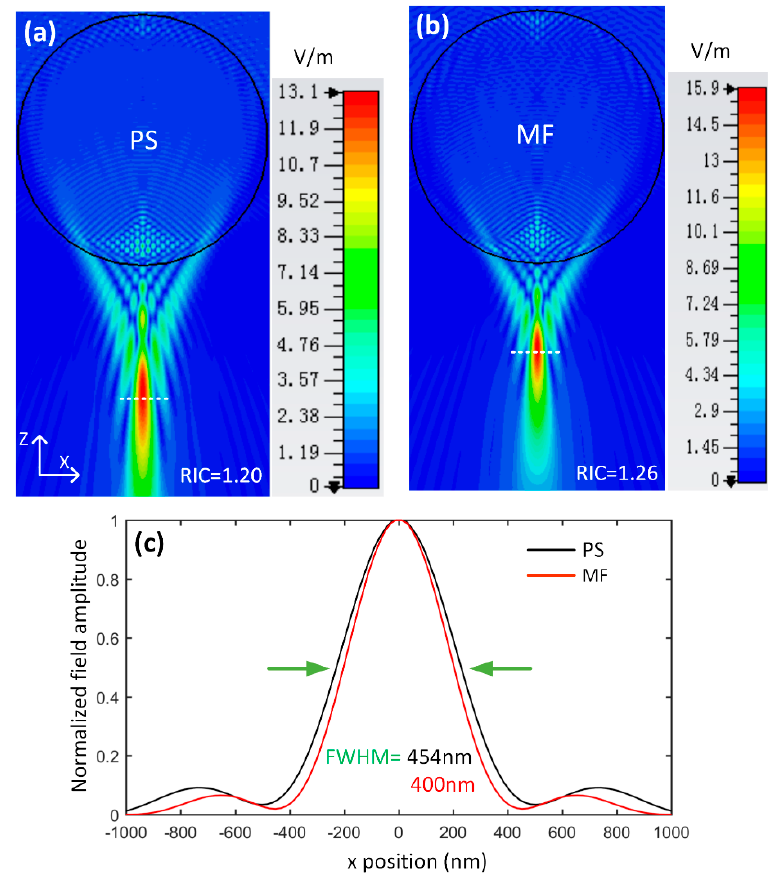
Figure 6. Numerical simulations of electric field distributions around a 10- μ m sphere, with different refractive indices in water medium: ( a ) PS sphere, refractive index contrast (RIC) = 1.20, ( b ) MF sphere, RIC = 1.26. ( c ) Normalized intensity in the full width at half maximum (FWHM) plane for the PS and MF sphere. The white dotted line represents the location of the FWHM plane.